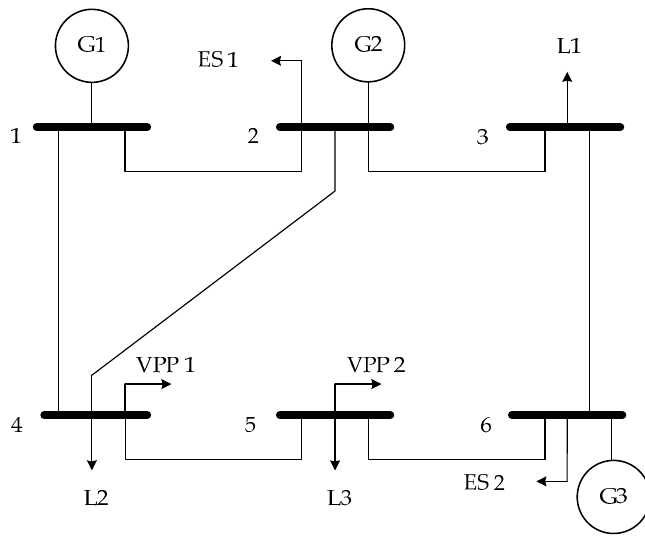
Figure 2. Topology of the modified six-bus test system.